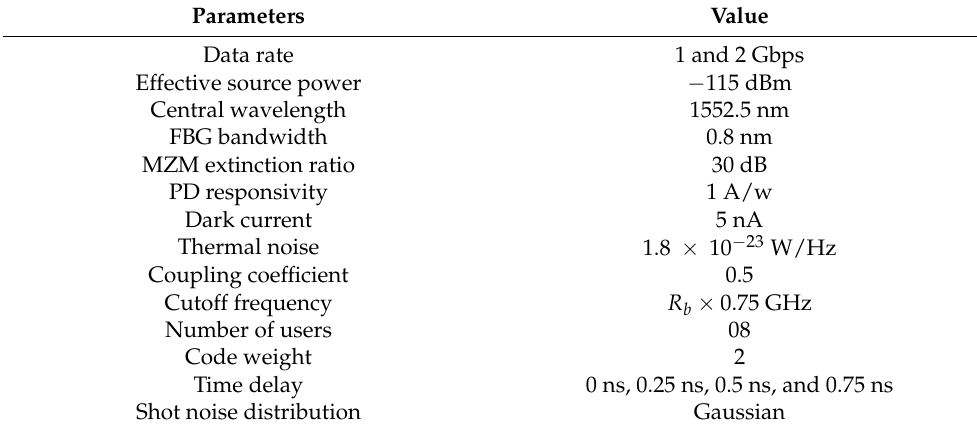
Table 6. Simulation parameters of a 3D-VWZCC network.